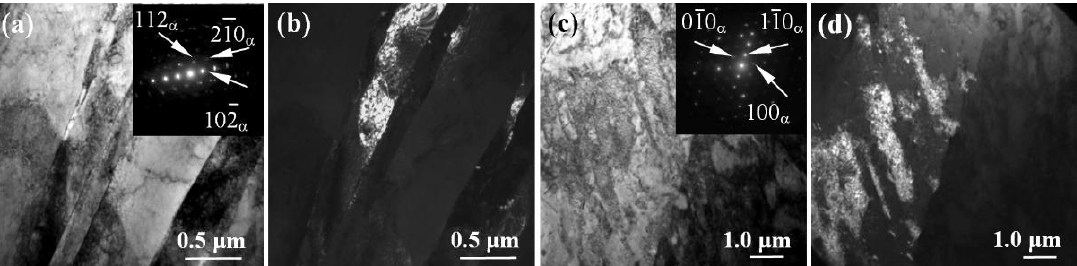
Figure 8. Microstructure of pure titanium in the CG state before fracture in the neck area: ( a , c ) — the BF TEM images with SAD patterns; ( b , d ) — the DF TEM images. Band structure ( a , b ) with cellular-network dislocation substructure ( c , d ).